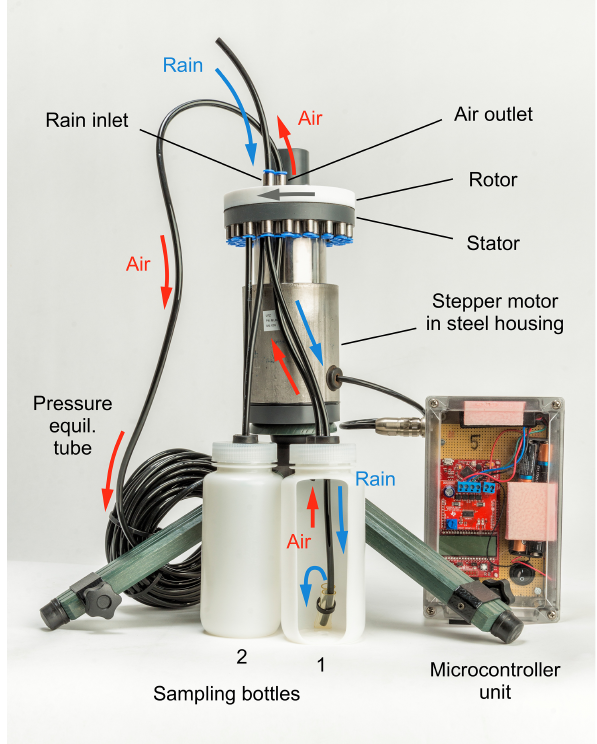
Figure 1. Overview of the automatic sampler principle (photo by André Künzelmann, UFZ). Water (blue arrows) flows from the rain inlet through the distribution unit and into the first bottle (cutaway view). Displaced air (red arrows) leaves the bottle and flows through the distribution unit and the air outlet into a 15m long pressure equi- libration tube. At the end of the sampling interval, the rotor is turned (grey arrow), leading the rain into the second